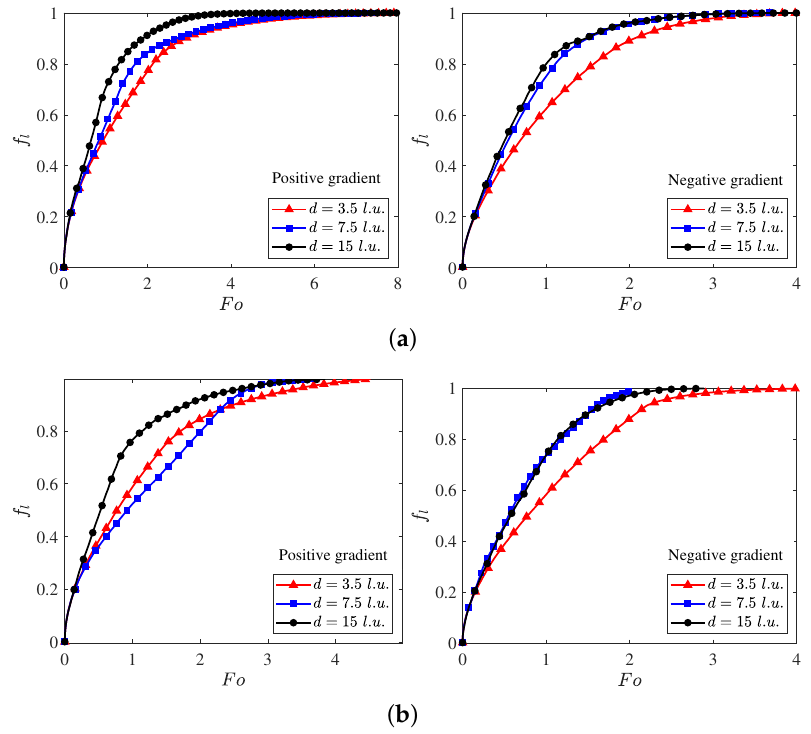
Figure 11. Comparisons of liquid fraction at different particle diameters for Ra = 10 6 , in which Ste = 0.1, and Pr = 0.2: ( a ) Case A; ( b ) Case